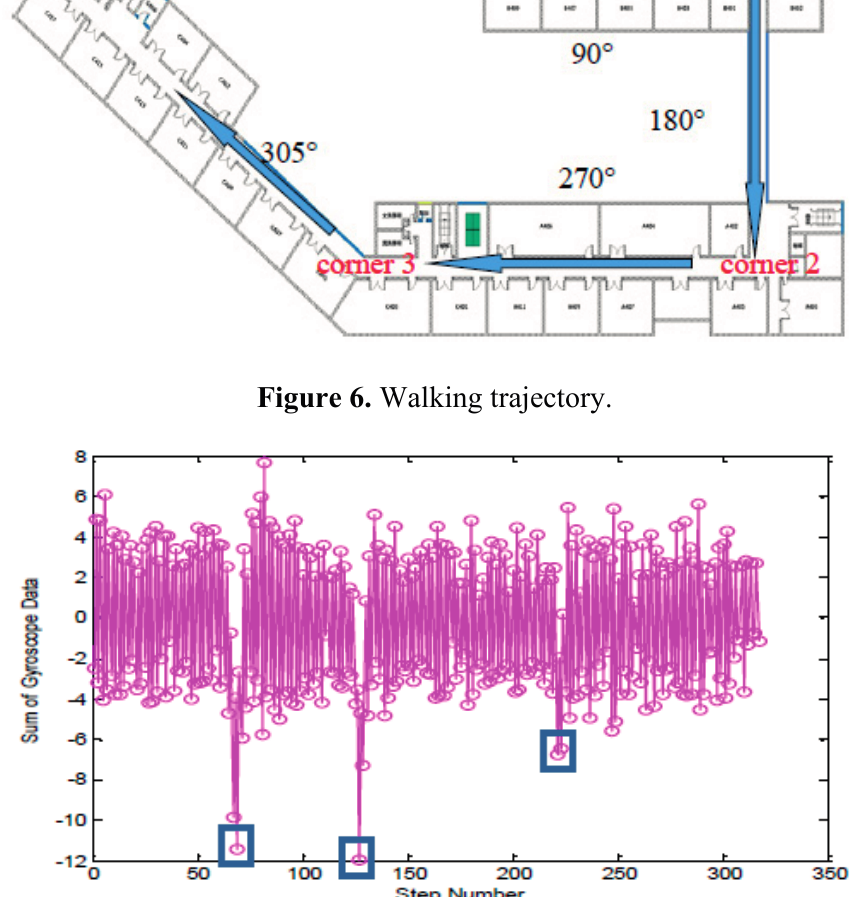
Figure 7. Analysis on the accumulated gyro